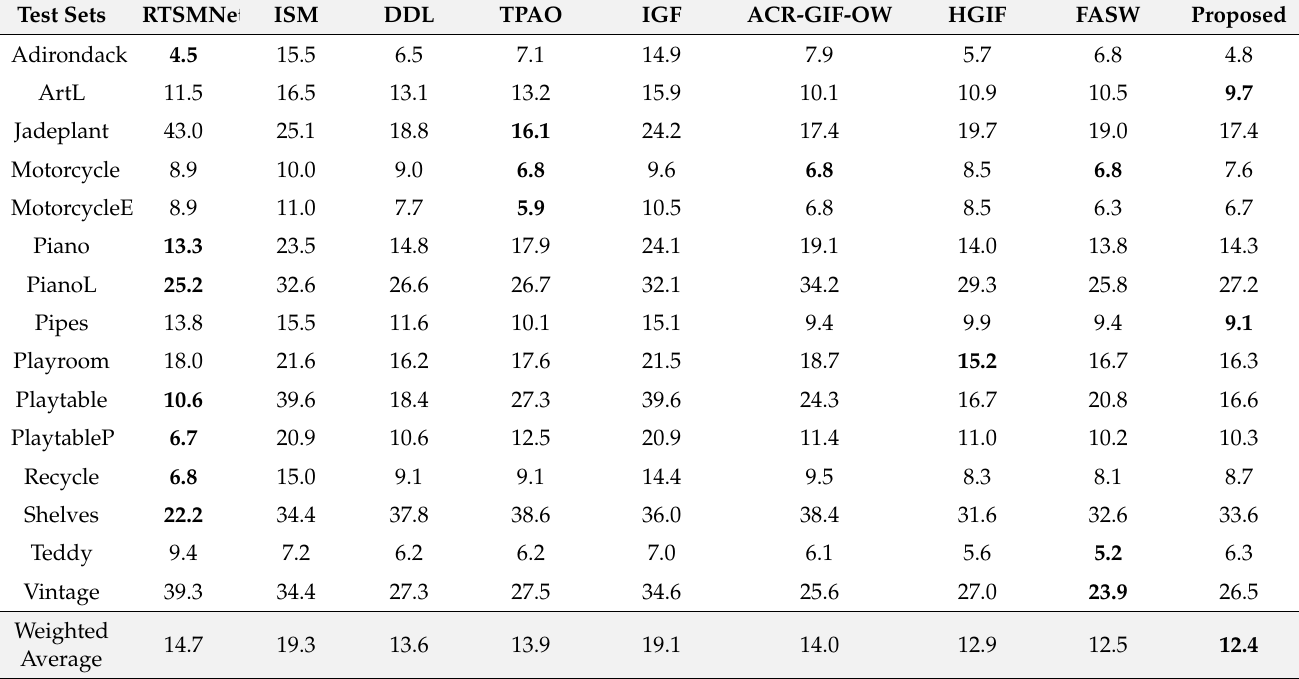
Table 2. Comparison of the error rates in the non-occluded region without refinements using different matching algorithms (%). In calculating the error rates, the error threshold = 1.0.